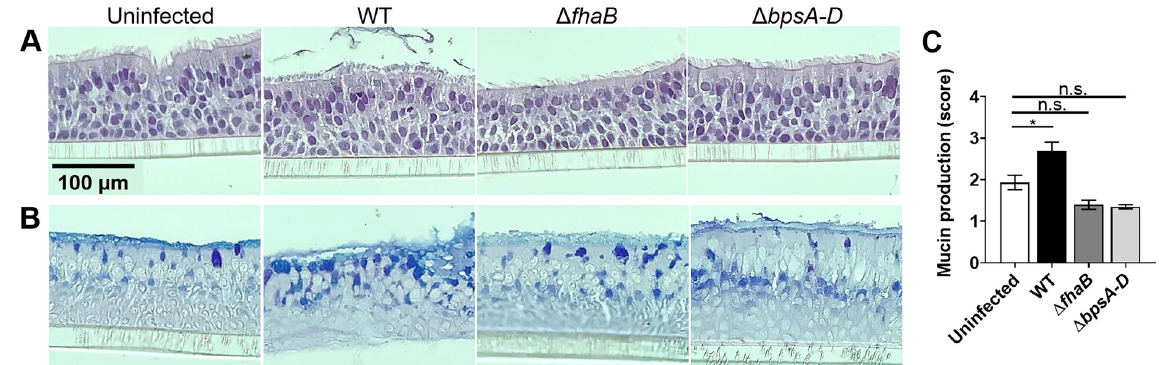
Fig 2. Bp induces mucin secretion in HBE cells. HBE cells were infected as described in the ‘Materials and Methods’ at an MOI of 10, for 24 h with different Bp strains. Fixed cells were, sectioned and stained with (A) Hematoxylin & Eosin, or (B) PAS/AB. (C) Semi-quantification of mucin production from PAS/AB-stained images. Images are representative of two biological replicates. Statistical differences were assessed by One-way ANOVA. � , p � 0.05; n.s., not significant.